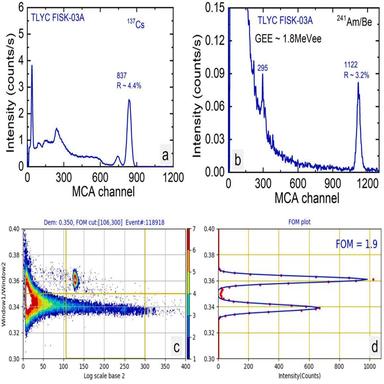
Characterization of a 13 × 10 × 10 mm3 TLYC crystal (grown and pre-processed at Fisk), encapsulated in a temporary can as a dual mode detector, conducted at RMD (a) 137Cs spectra collected with 2 μs amplifier shaping times. (b) Energy equivalent Am-Be spectra collected with 2 μs amplifier shaping times. (c) PSD scatter plot created using the waveforms generated by thermalized Am-Be neutron source in the TLYC crystal. (d) Projection of the events in region in the scatter plot results in FOM of 1.9.